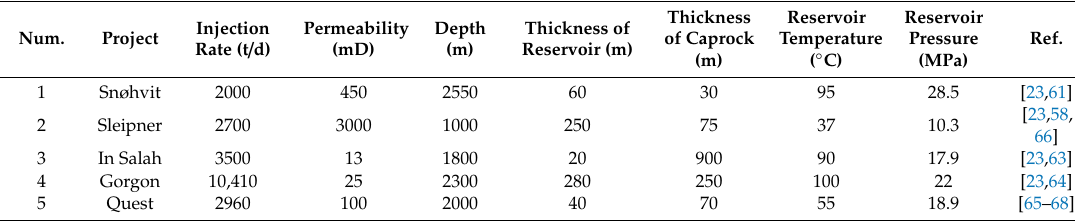
Table 2. Large-scale CCS project in saline